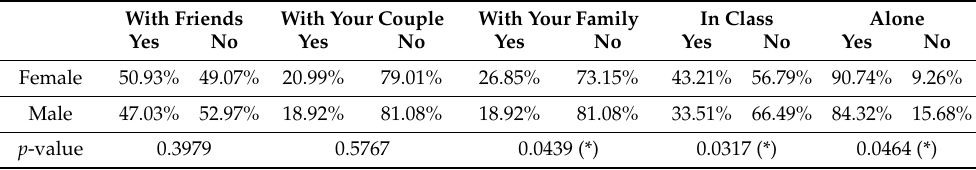
Table 5. Situations you are usually in when you interact on the Internet. With Friends With Your Couple With Your Family In Class Alone